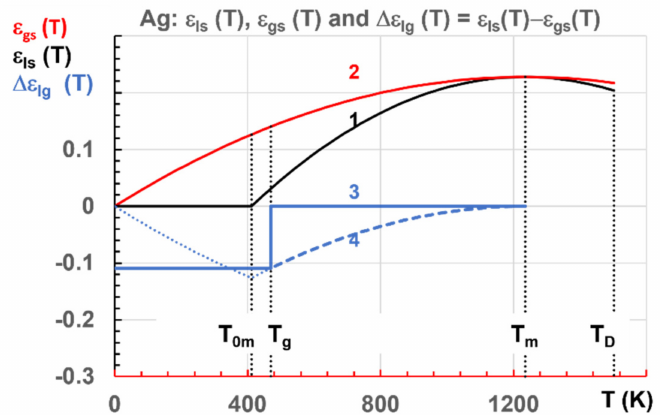
Figure 3. Ag enthalpy coefficients: liquids 1, 2 and 3–4 versus temperature in Kelvins. T g = 469.34 K, T 0m = T m /3 = 411.63 K, T D = 1489 K, ε ls0 = ε gs0 = 0.22766, θ 2 0m = 0.444445 and θ 2 0g = 1 in Equations